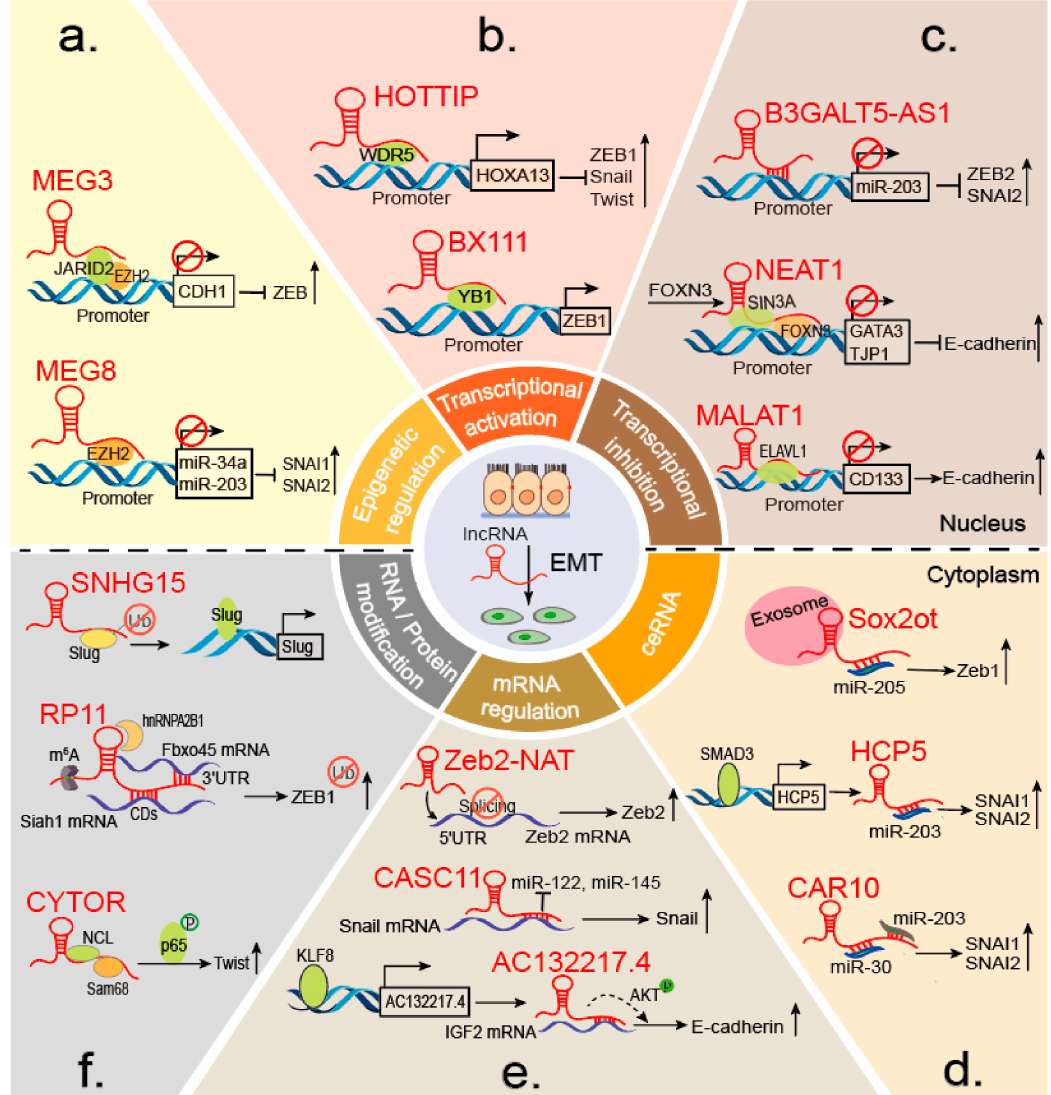
Figure 3. LncRNAs regulate EMT at di ff erent levels. ( a ) LncRNAs regulate RNA-protein interactions at the epigenetic level. Both MEG8 and MEG3 suppress the expression of downstream target genes by interacting with EZH2, resulting in EMT marker upregulation. ( b–c ) During transcription, lncRNAs function via RNA-TF or RNA-DNA (e.g., B3GALT5-AS1) interactions. LncRNAs act as guides and molecular sca ff olds for TF activation (e.g., HOTTIP and BX111) or target gene repression (e.g., MALAT1 and NEAT1) to regulate EMT-related genes such as ZEB1 and E-cadherin. Furthermore, lncRNA B3GALT5-AS1 directly binds the miRNA-203 promotor to repress miR-203 expression, upregulate SNAI2 and ZEB2, and induce EMT. ( d ) LncRNAs (e.g., CAR10 and HCP5) and exosomal lncRNAs (e.g., Sox2ot) act as ceRNAs by competitively binding miRNAs to increase EMT TF expression. ( e ) LncRNAs a ff ect mRNA splicing (e.g., Zeb2-NAT) and stability (e.g., lnc-ATB and AC132217.4) to modulate EMT. ( f ) LncRNAs regulate protein and mRNA modifications to manipulate EMT. They also act as sca ff olds to recruit proteins and impact protein phosphorylation and ubiquitination (e.g., SNHG15 and CYTOR). Additionally, m 6 A methylation can induce lncRNA expression (e.g., RP11) by increasing lncRNA accumulation in